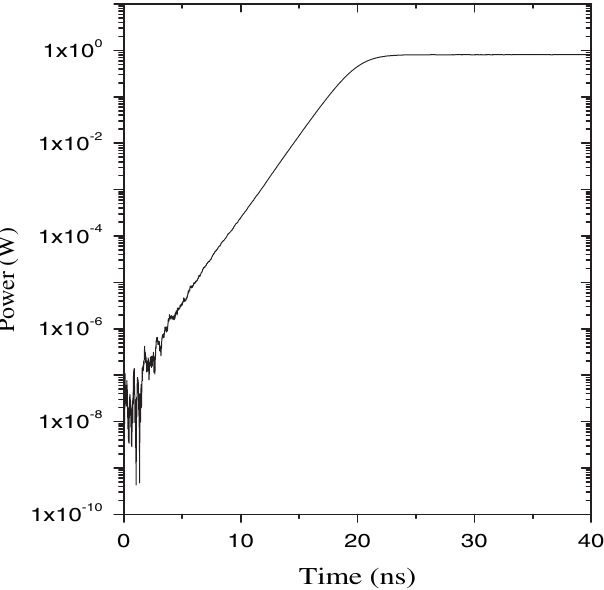
FIG. 4. Evolution of power in SP-BWO for the parameters mentioned in the text. The electron beam current is assumed to be 30